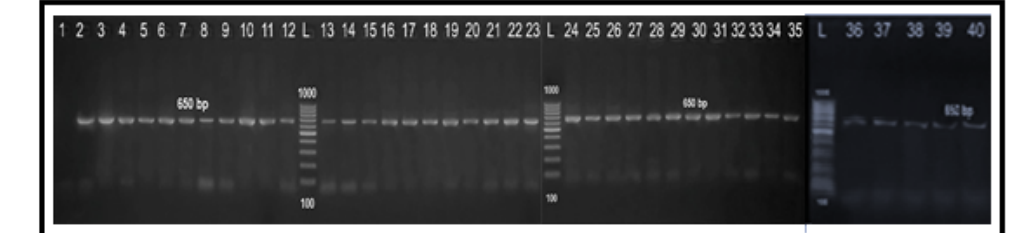
Figure 4. Agarose gel electrophoresis showing typical amplification products of 23S rRNA gene for confirmation of genus Campylobacter . Lane L: 100 bp DNA ladder “Marker”, lane 1: negative control (PCR grade water), lane 2: positive control ( C. jejuni NCTC11322), lanes 3–15: positive Campylobacter isolates from human stool swabs and lanes 16–40: positive Campylobacter isolates from chicken samples.